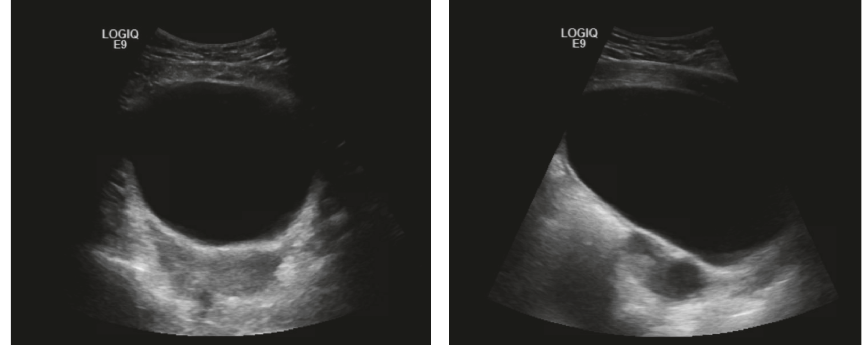
Figure 2: Abdominal ultrasound performed prior to cyst aspiration demonstrating recurrent, simple paravaginal